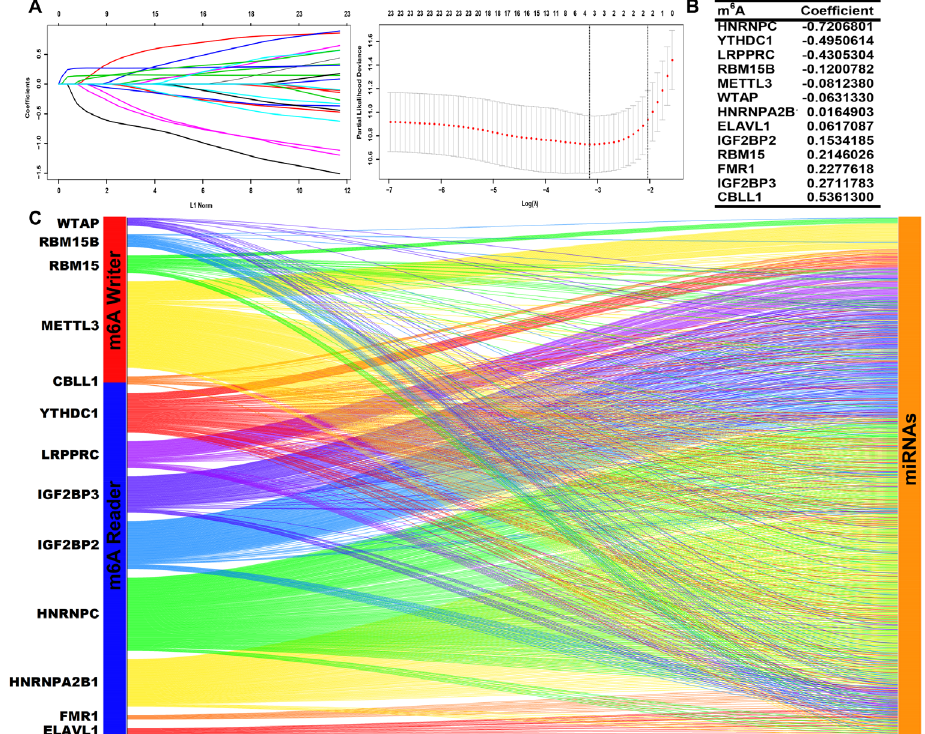
Figure 1. Identification of prognostic m 6 A genes in LGG patients. (A, B) LASSO regression analysis using 10-fold cross-validation; (C) Sankey plots of m 6 A genes and m 6 A-related miRNAs